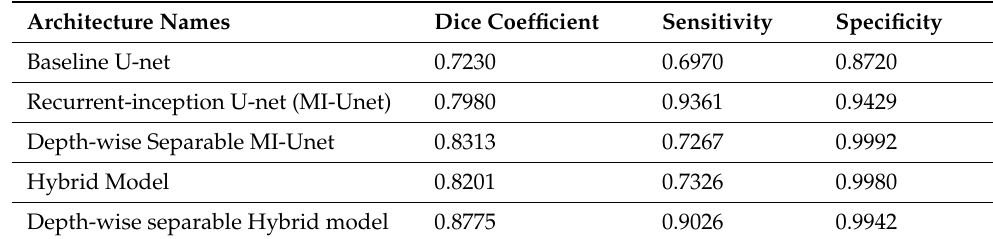
Table 2. Performance Comparison.